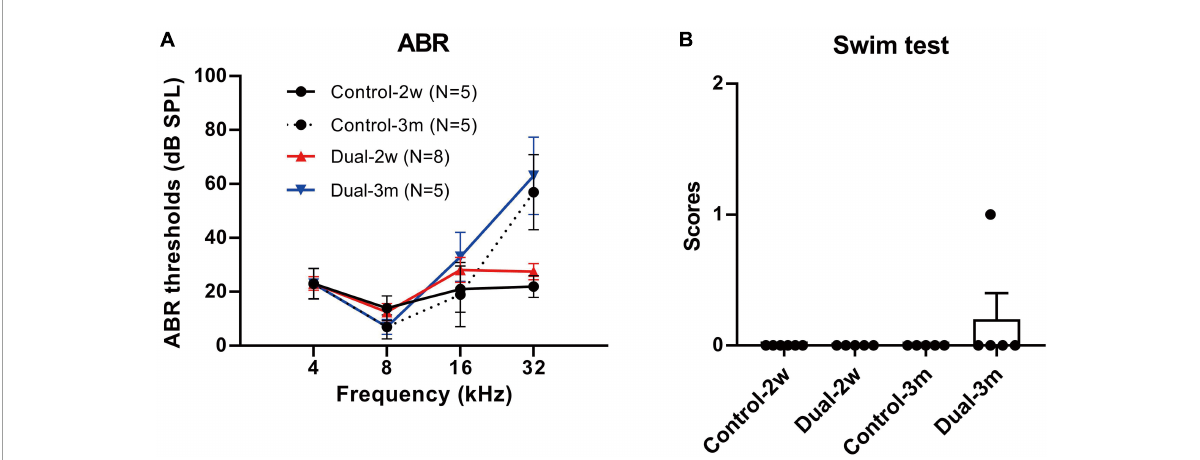
FIGURE6 ABR thresholds and swim test scores 2 weeks and 3 months after co-transduction of dual-AAV-ie vectors in normal adult mice. (A) There is no significant difference in ABR thresholds between mice 2 weeks or 3 months after the injection of dual-AAV-ie vectors and control animals (i.e., age-matched mice without surgery) according to Student’s t- test at each frequency. (B) Swim test scores show no significant difference between the groups according to Student’s t -test. Data are mean ±